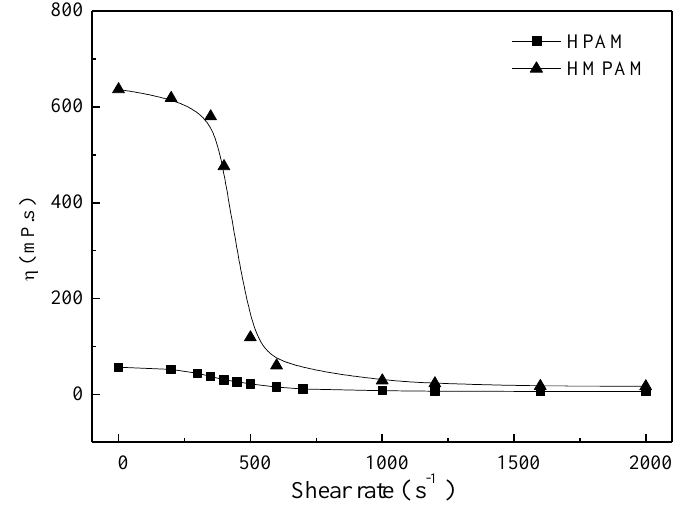
Figure 5. The shear behavior of polymer solutions with 1500 mg/L at 45 ◦ C. To better explain shear tolerance performance of HPAM and HMPAM, both polymer solutions with 1500 mg/L were sheared at a certain shear rate for 10 min and then the intrinsic viscosity measurement and molecular weight calculation were conducted as described in Section 2.4. Figures 6 and 7 describe the intrinsic viscosity and the molecular weight of both HMPAM and HPAM as a function of shear rate. The intrinsic viscosity and molecular weight of HPAM decreased dramatically with the increasing shear rates, which indicated that irreversible mechanical degradation on molecular weight occurred for the HPAM molecule. As to HMPAM, mechanical degradation did not obviously occur during the shear process because the dissociation process of the physical crosslinking network structure is reversible and the hydrophobic groups can form new association after removing the shear